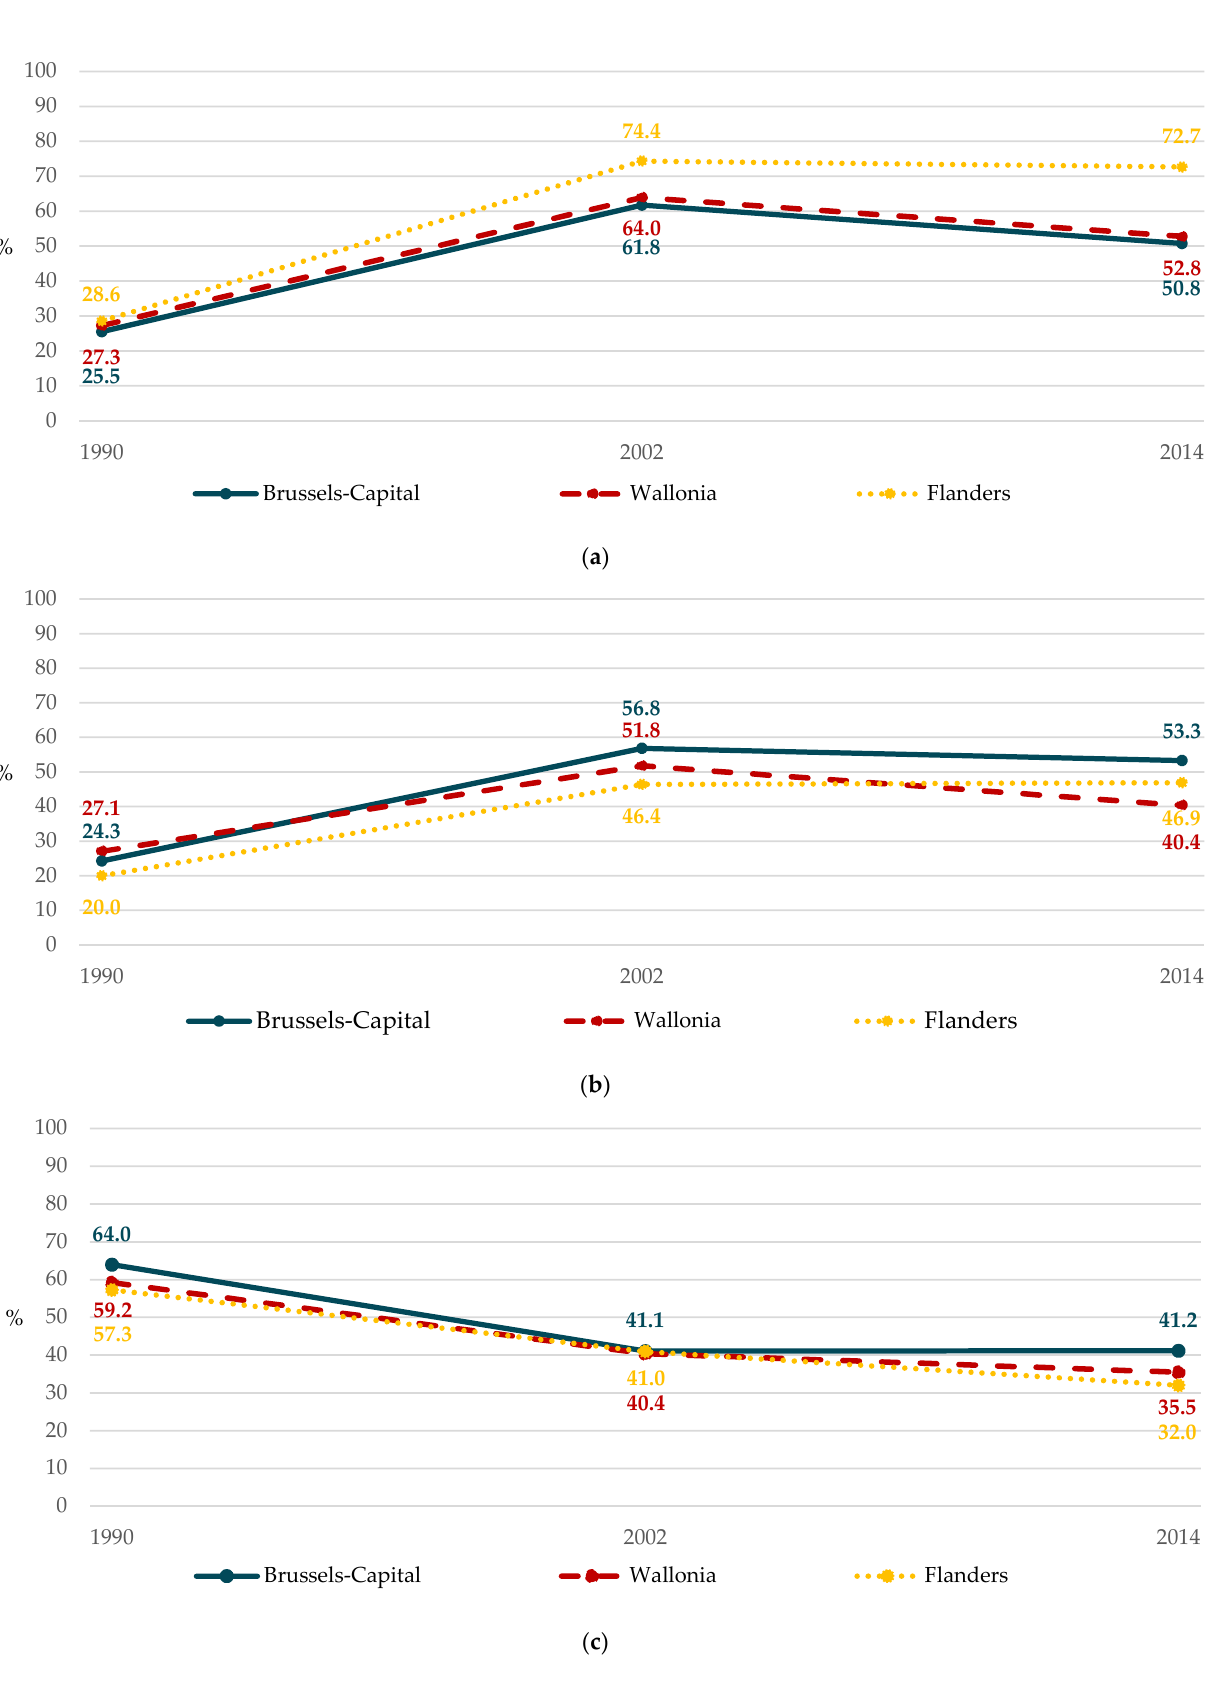
Figure 2. Changes in prevalence of food consumption according to the school region between 1990 and 2014 (HBSC, Belgium, 1990–2002–2014): ( a ) non-daily fruit; ( b ) non-daily vegetable; ( c ) daily sugar-sweetened beverage.